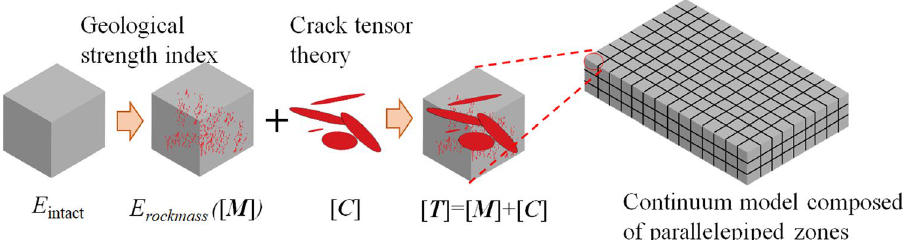
Fig. 3 Procedure to construct an equivalent continuum